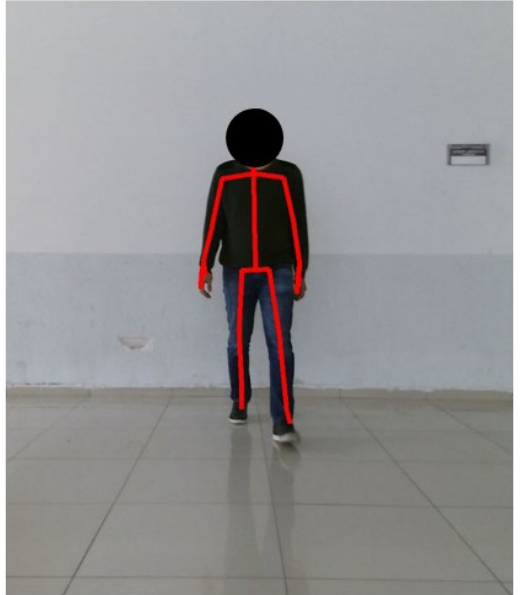
Fig. 2. Data collection setting and an exemplary moment of data